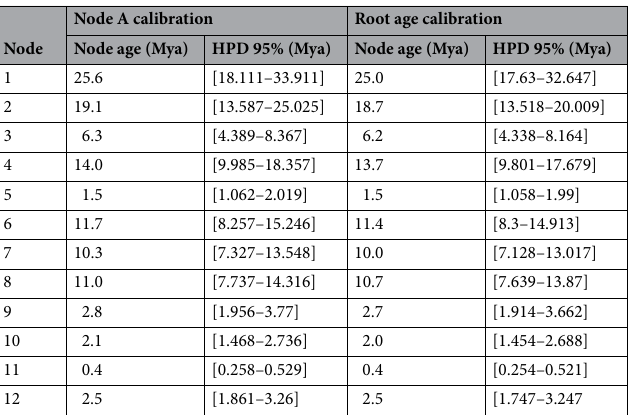
Table 2. Estimated ages and 95% higher posterior densities (HPD) for each node in the best mitochondrial tree according to Bayes Factor scores obtained in BEAST under the two alternative calibration schemes (MRCA of node A and tree root after Adamowicz et al. 14 ; see text for details).